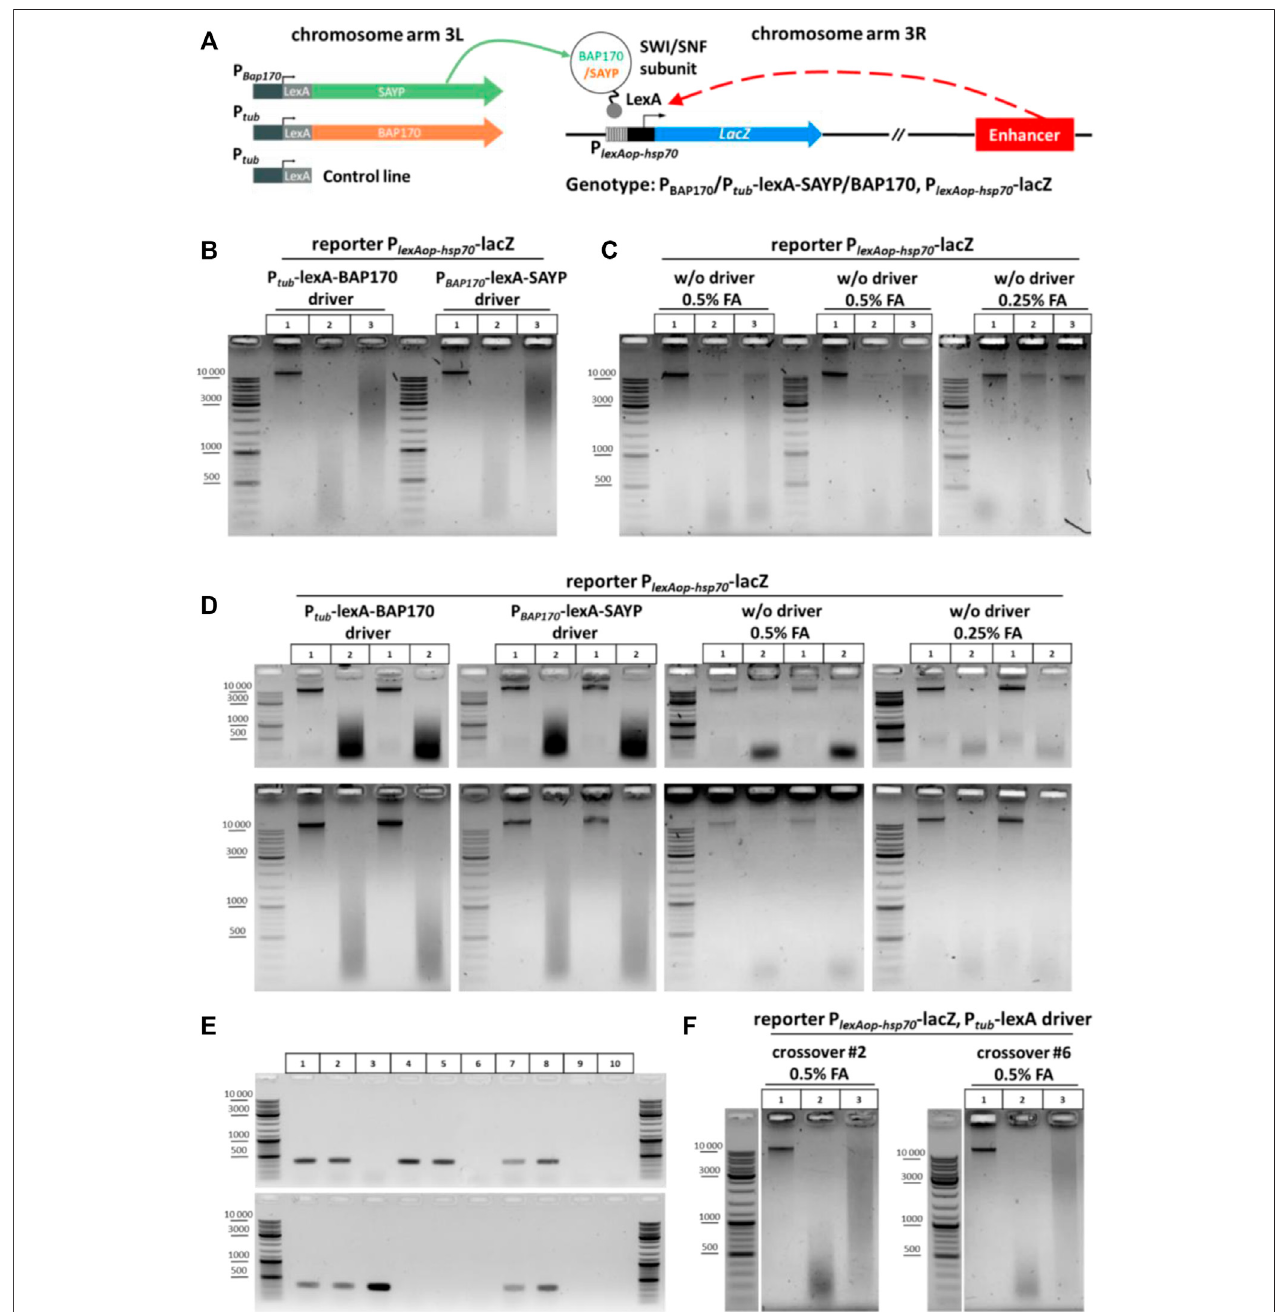
FIGURE 3 | General scheme of the experiment with transgenic larvae, screening of crossovers, and 3C libraries obtained from the transgenic larvae. (A) Genetic structure of transgenic fl ies and a general arrangement of the experiment with transgenic larvae used to determine the role of SAYP or the BAP170 Brahma/SWI/SNF subunitsinenhancer – promoterinteractions.TheSWI/SNFsubunitsBAP170andSAYPtetheredtothereporterpromoterinduceactivationofthereporterinanadjacent enhancer-dependentmanner. (B) 3ClibrariespreparedfromlarvaecarryingthereporterP lexAop-hsp70 -lacZtransgeneinthepresenceofeitherP tub -lexA-BAP170or P BAP170 -lexA-SAYP driver. The combinations of transgenes are indicated above the electrophoretic pictures. Theexperiment was performed as shown in Figure 2B for larvae except that 150 larvae were collected and 50 mg of larval cell material was taken for 3C library preparation. Lane 1, chromatin integrity control; lane 2, chromatin digestion control; lane 3, ligation mixture (3C sample). At least seven independent 3C libraries were prepared for each genotype. A representative example is shown for two 3C libraries. (C) 3C libraries prepared from larvae carrying the P lexAop-hsp70 -lacZ reporter only. 3C libraries and controls were prepared as shown in (A) . Lane 1, chromatin integrity control; lane 2, chromatin digestion control; lane 3, ligation mixture (3C sample). At least seven independent 3C libraries were prepared. Three biological replicates obtained after fi xation with different FA concentrations are presented. (D) Electrophoretic analysis of chromatin integrity controls and restriction digestion controls prepared from larvae carrying the P lexAop-hsp70 -lacZ reporter with or without the P tub -lexA-BAP170 or P BAP170 -lexA-SAYP driver. The controls were